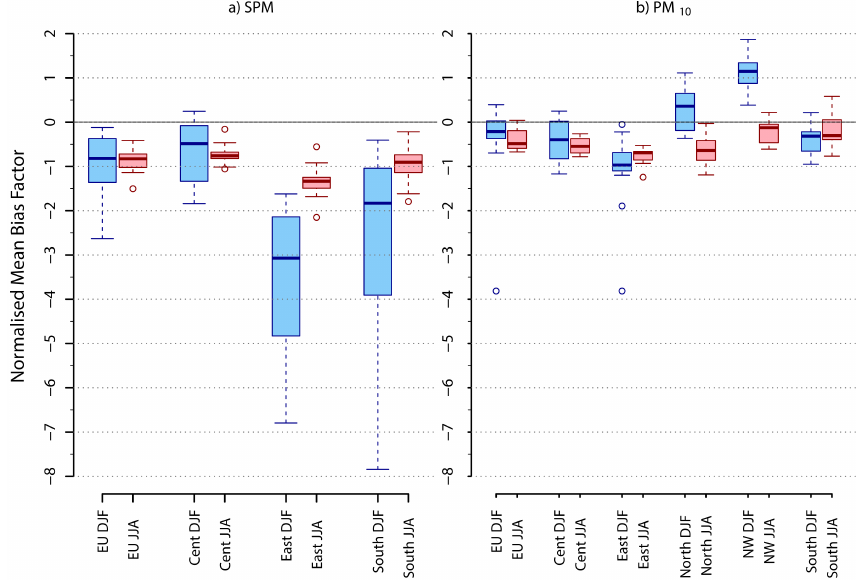
Figure 9. European and sub-regional normalised mean bias factors for summertime (red) and wintertime (blue) (a) SPM and (b) PM 10 mass concentrations across all the years that data were available. The solid line shows the median value, the boxes show the 25th and 75th percentile values with the error bars showing the maximum and minimum values and the circles representing outliers (values > 1.5 × interquartile range).